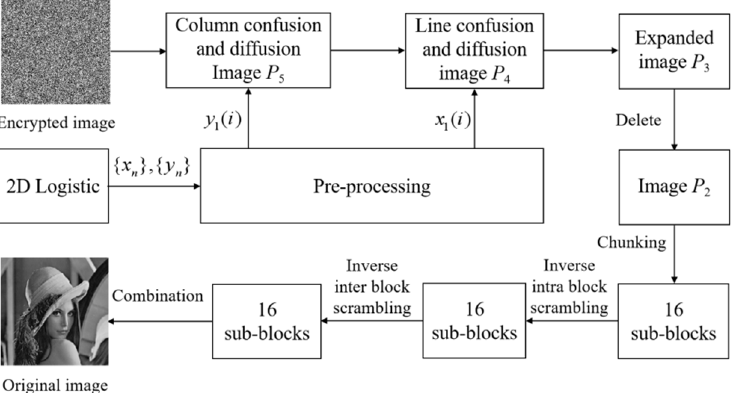
Figure 5. Image decryption framework.